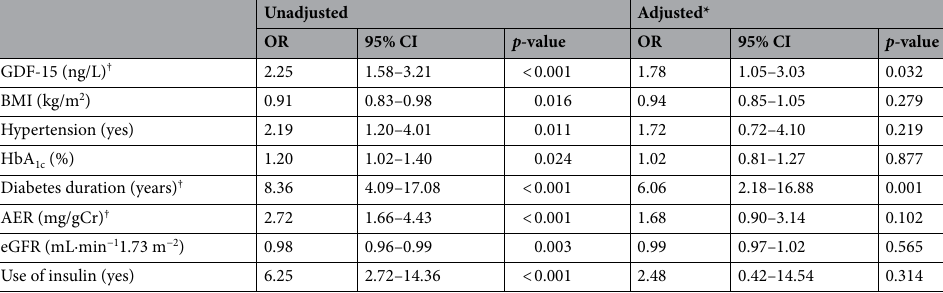
Table 3. Logistic regression models for the association between GDF-15 levels and diabetic retinopathy in patients with type 2 DM. † Values were log-transformed prior to analyses. Adjusted for age, sex, hyperlipidemia, hs-CRP † , and use of OHAs. AER, albumin excretion rate; BMI, body mass index; CI, confidence interval; DM, diabetes mellitus; eGFR, estimated glomerular filtration rate; GDF-15, growth differentiation factor-15; HbA 1c , glycated hemoglobin; hs-CRP, high-sensitivity C-reactive protein; OHAs, oral hypoglycemic agents; OR, Odds ratio.